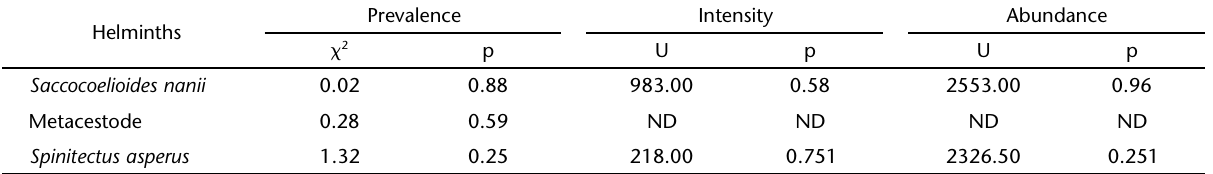
Table III. Analysis of the influence of the sex of P. argenteus from the Upper São Francisco River, Minas Gerais, on the parasitic prevalence ( (cid:2) 2 ), intensity (U) and abundance (U). ( (cid:2) 2 ) Chi-square with Yate’s correction, (U) Mann-Whitney test. Helminths